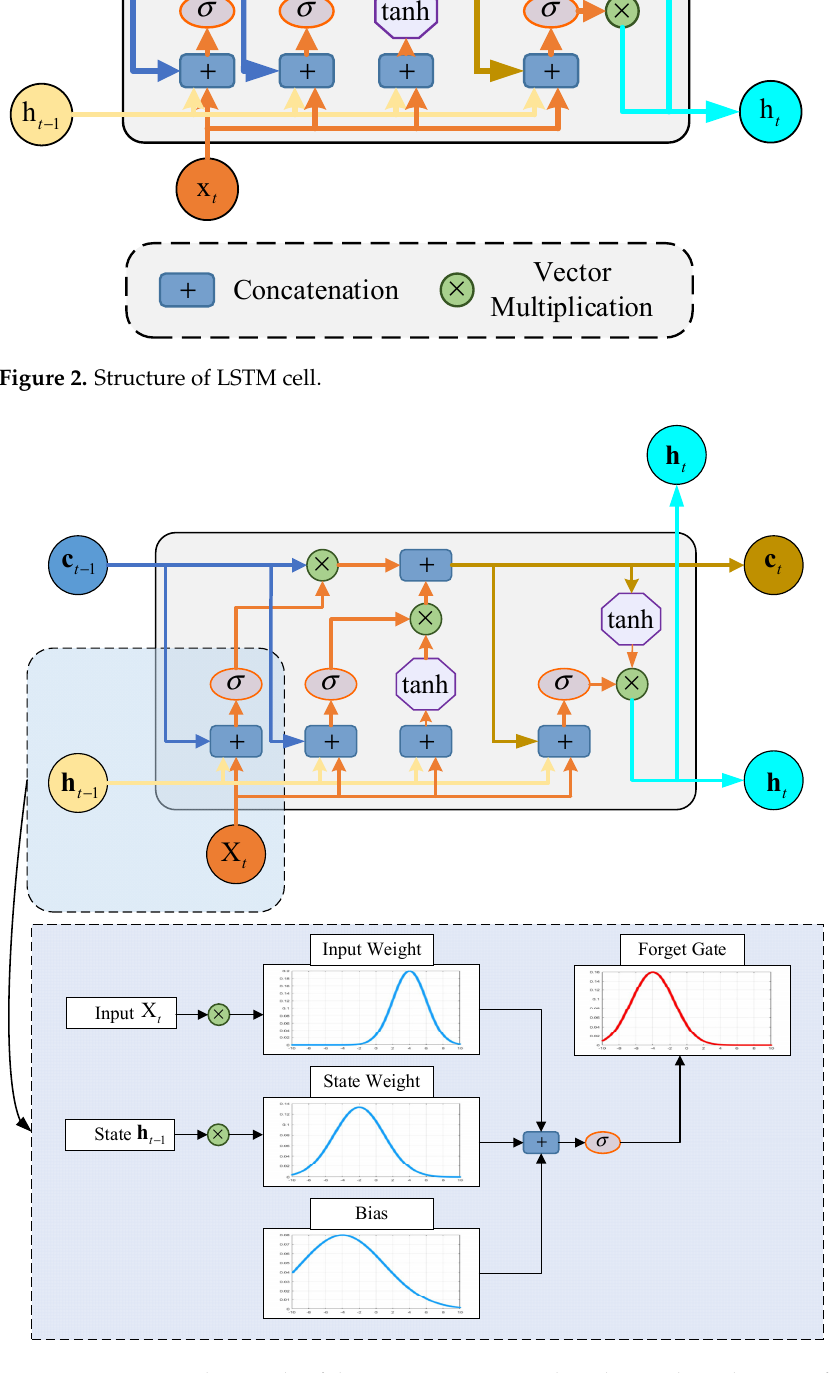
Figure 3. A proposed example of the LSTM-BDL network with an enlarged image of the forget gate.